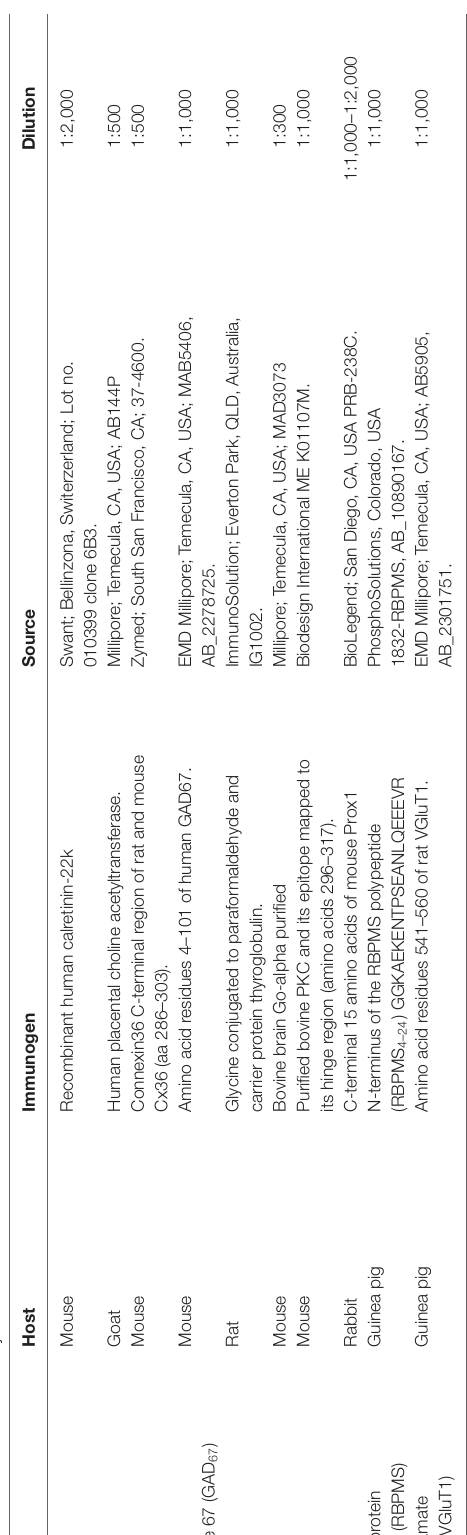
( Table 1 ) diluted in PB with 0.3–0.5% Triton X-100 and 0.1% NaN 3 , overnight at 4 ◦ C. Retinal sections were washed three times for a total of 30 min with 0.1 M PB, and the corresponding secondary antibodies (1:1,000; Invitrogen, Carlsbad, CA) were then applied for 1–2 h at RT in the dark. The tissues were washed three times for 10 min each in 0.1 M PB, and the retinal sections were then coverslipped with Aqua Poly/Mount